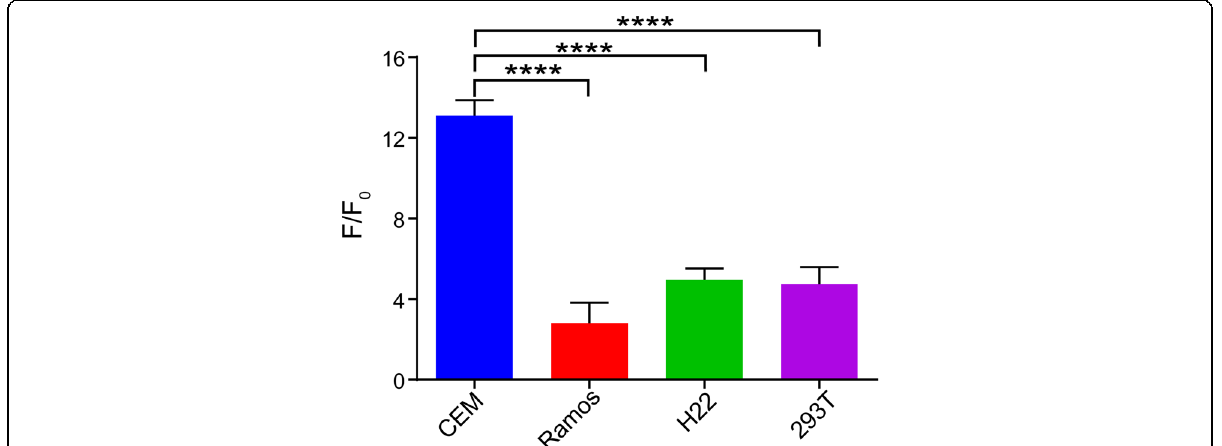
Fig. 7 Specificity of the fluorescent aptasensor for CEM. The fluorescence intensity rate ( F / F 0 ) of GO-apt fluorescent aptasensor in the presence of CEM cells, Ramos cells, H22 cells, and 293T cells, respectively (1 × 10 6 ), where F 0 and F are the fluorescence intensity without and with detection cells at 518 nm. Excitation 490